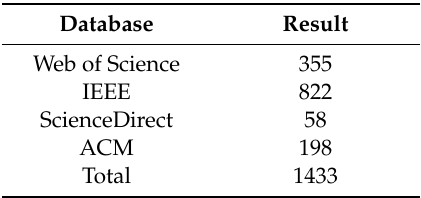
Table 1. Results in the first round search.